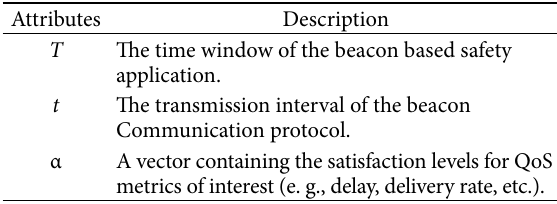
Table 1. Attributes of safety applications